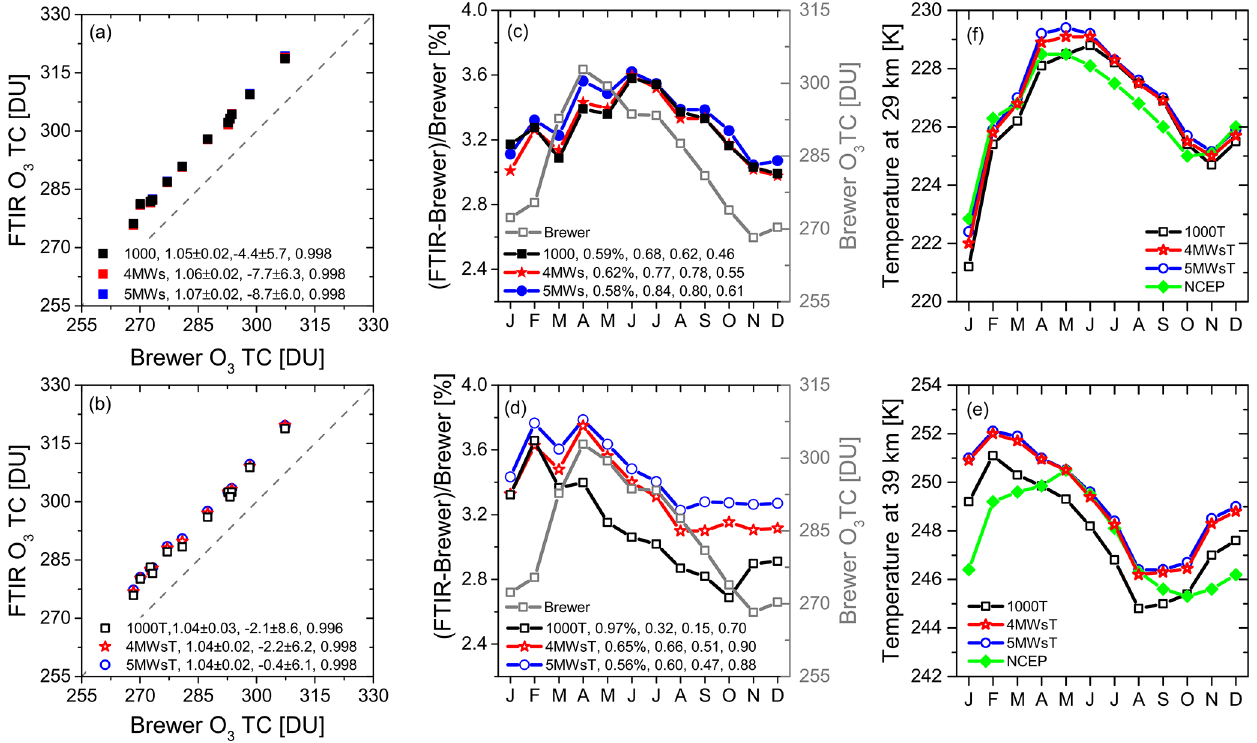
Figure 6. Summary of the FTIR–Brewer comparison at a seasonal scale for the 2009–2018 period. (a, b) Scatter plots of the Brewer and FTIR O 3 TCs for the setups 1000/4MWs/5MWs and 1000T/4MWsT/5MWsT, respectively. (c, d) Averaged annual cycles of the Brewer O 3 TC and RD for the setups 1000/4MWs/5MWs, and 1000T/4MWsT/5MWsT, respectively. (e, f) Averaged annual cycles of the atmospheric temperature at 29km and 39km, respectively, retrieved from the setups 1000T, 4MWsT, and 5MWsT, as well as the NCEP database. The legends in (a) and (b) display the slope, offset, and Pearson correlation coefficient of the least-squares fit, and the legends in (c) and (d) show the amplitude of the RD annual cycle (in %), the Pearson correlation coefficient between the RD and Brewer O 3 TC annual cycles, and the annual cycle of atmospheric temperature (at 29 and 39km,